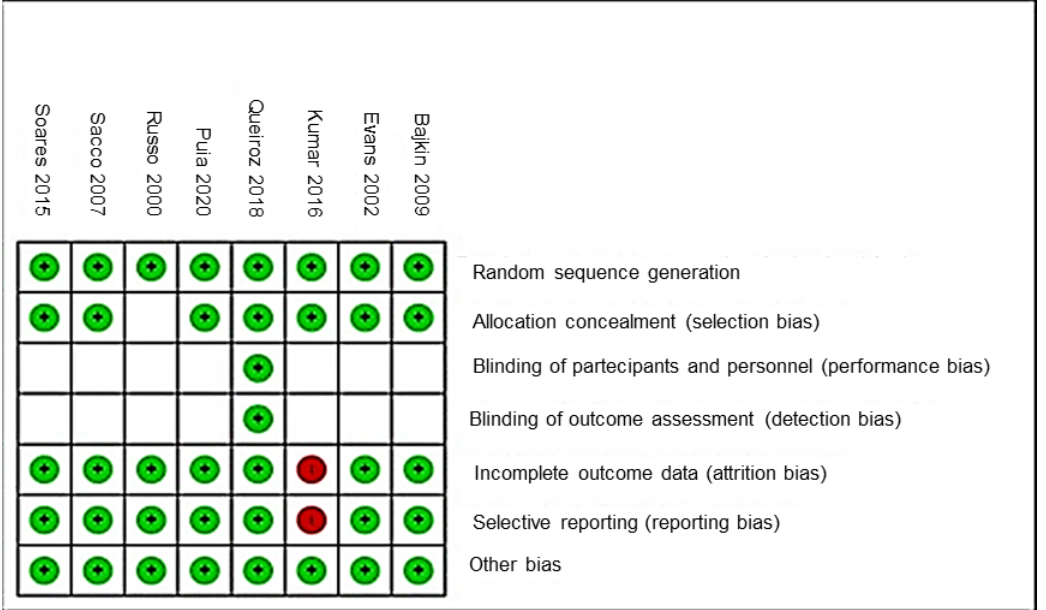
Figure 3. Risk of bias summary about each risk of bias item for each included study (green dot: low risk of bias; red dot: high risk of bias) [8–15].